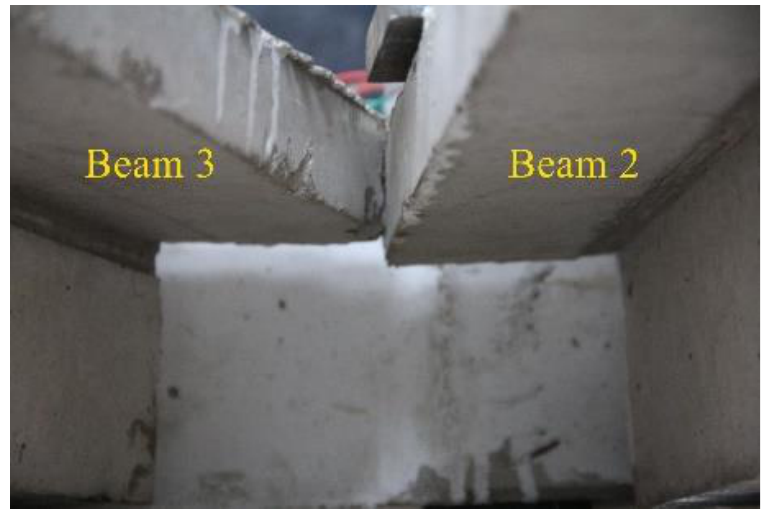
Figure 11. Collision between beams 2 and 3.